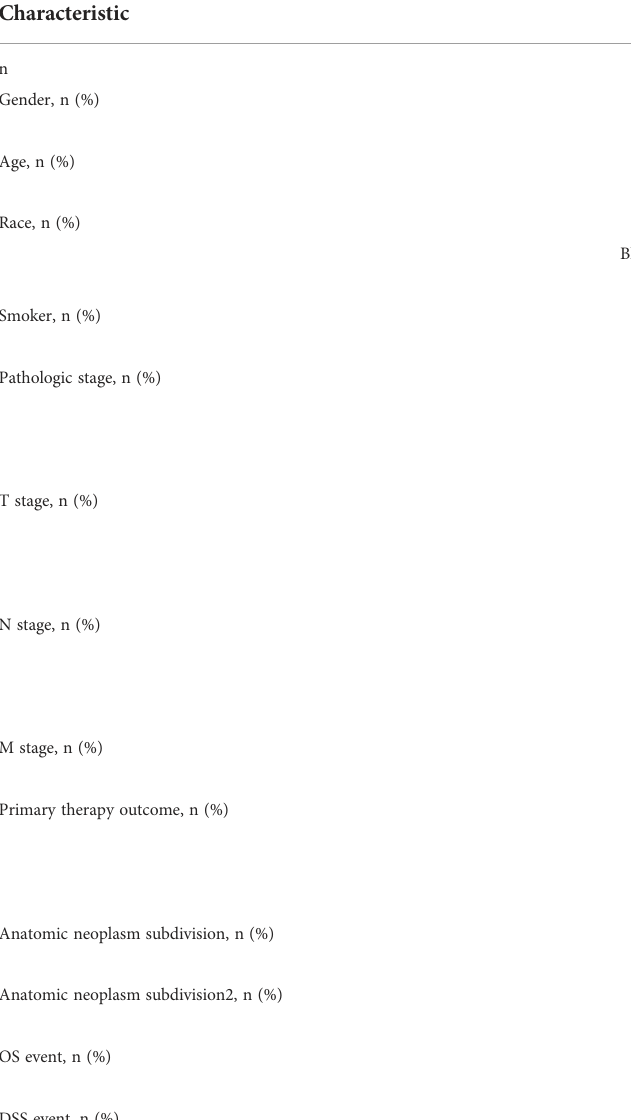
TABLE 1 Baseline Table of 535 NSCLC Patients in TCGA Database.